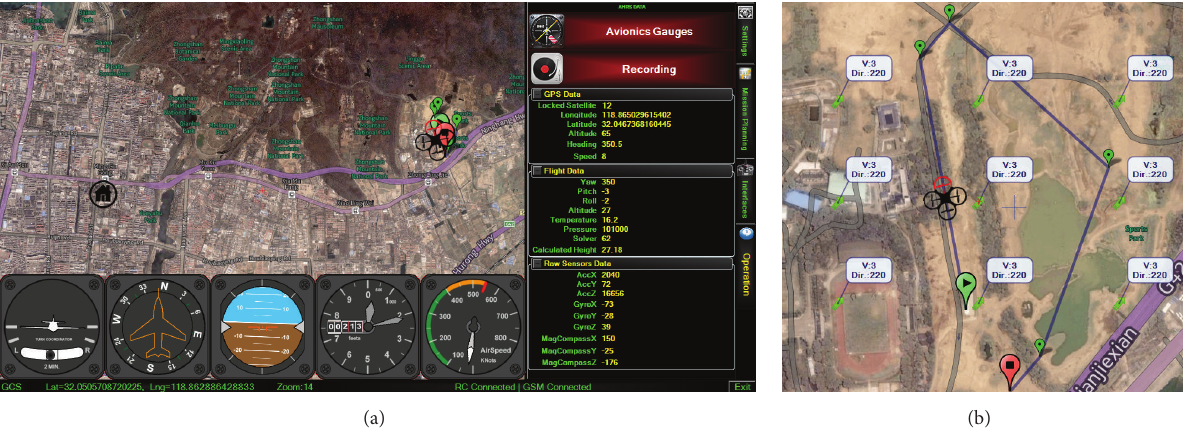
Figure 15: Proposed Ground Control Station GUI snapshot. (a) Operational panel and (b) mission trajectory with synthetic weather data